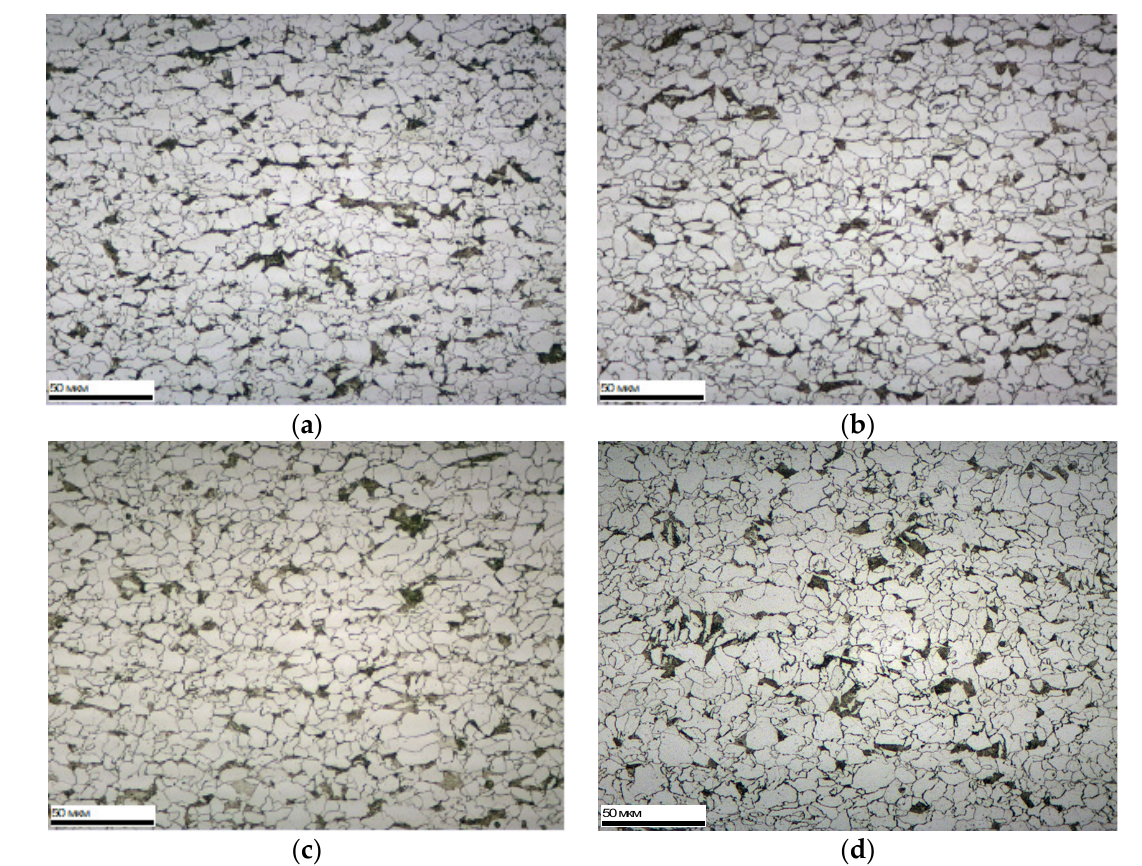
Figure 3. Microstructure of steels: ( a ) Steel No 2; ( b ) Steel No. 5; ( c ) Steel No. 14; ( d ) Steel No. 17.